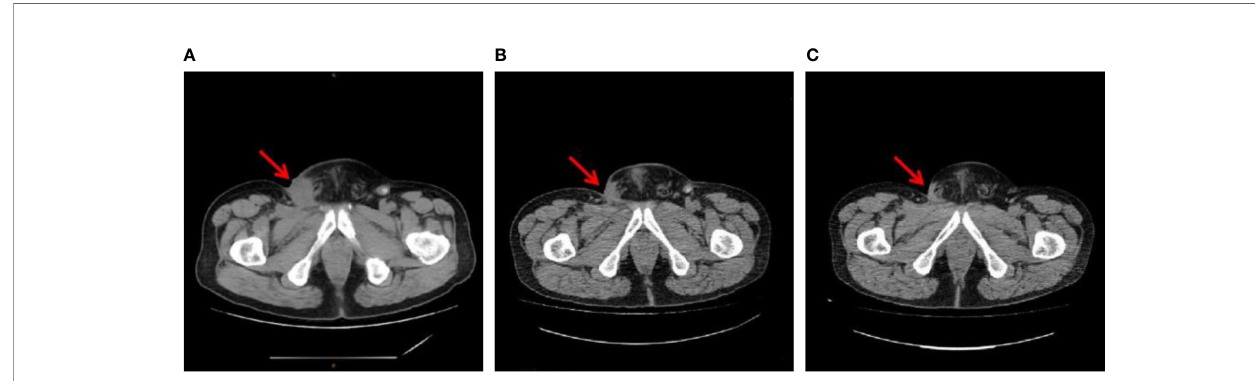
FIGURE 2 | Inguinal metastasis imaging of patient B (A) before sintilimab plus chemotherapy (June 13, 2019), (B) 6 months after sintilimab plus chemotherapy (December 20 2019), and (C) 2 months after the end of sintilimab maintenance therapy (September 08,